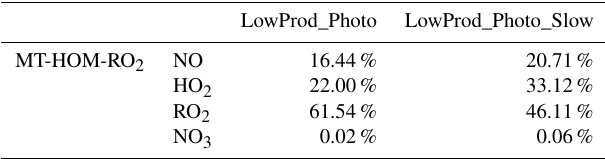
Figure 5. Annual averaged vertical profiles of three dominant re- action pathways of MT-HOM-RO 2 at Centreville, AL, USA, and over the Amazon near Manaus from the LowProd_Photo (solid lines) and LowProd_Photo_Slow (dashed lines) simulations. Reac- tion with NO 3 contributes < 1%; thus, it is not shown here. Table 3. Global PBL-averaged MT-HOM-RO 2 fates weighted by gridded MT-HOM-RO 2 concentrations on land.